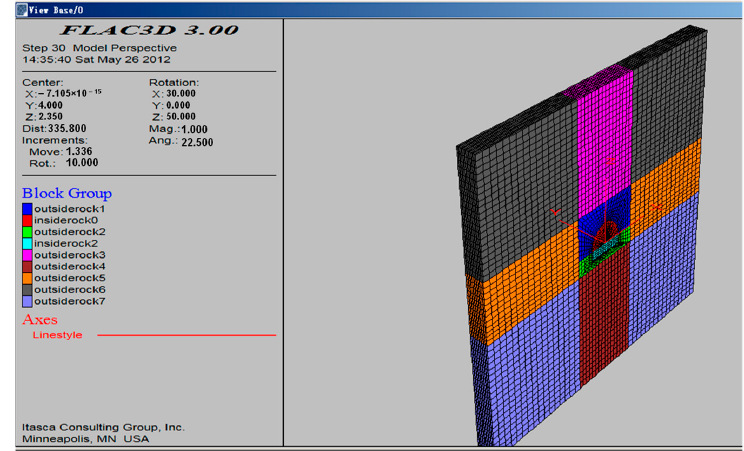
Figure 12. Plane view of finite element model.